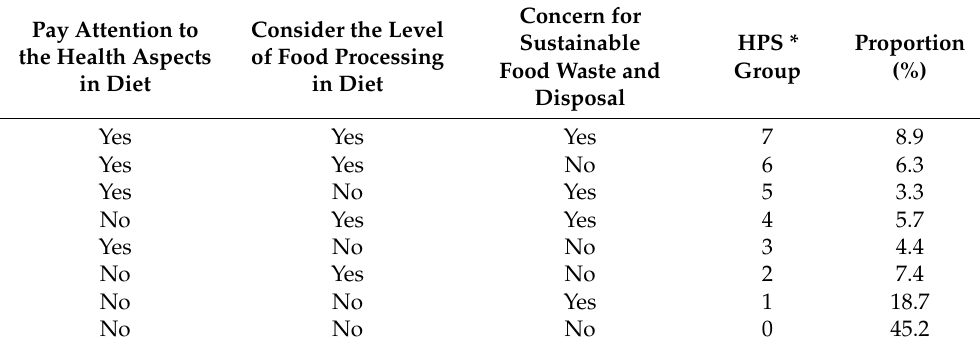
Table 4. Population groupings based on attitude towards health, processing, and sustainable food waste and packaging disposal (HPS), n = 540 Australian adults 18 years and over. Concern for Consider the Level Pay Attention to HPS * Sustainable of Food Processing the Health Aspects Group Food Waste and in Diet in Diet Disposal